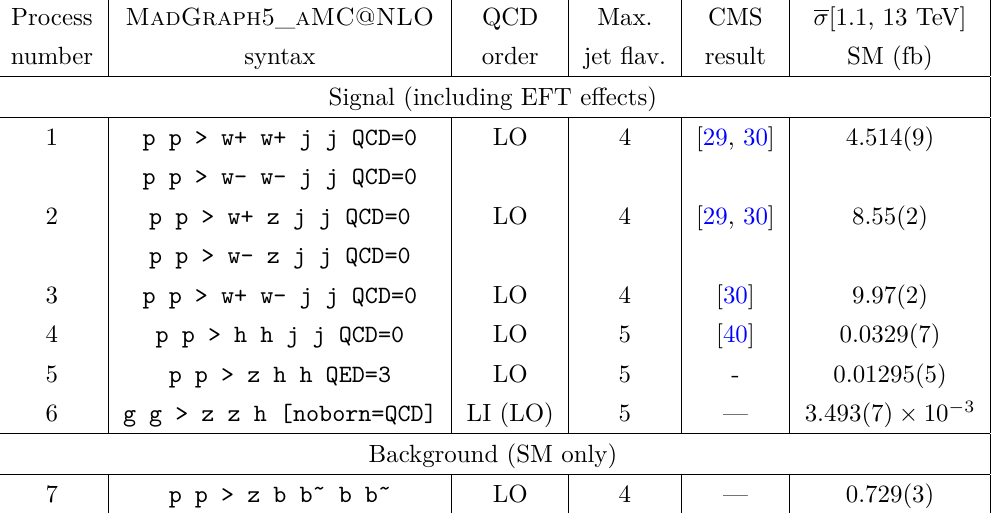
Table 1 . LHC processes of interest studied in the present work, numbered according to the main text. The number of active flavours considered in protons and jets is also listed. σ [ m ] min , m max is the cross section in the interval m , with m being the invariant mass of the min ≤ m ≤ m max produced di- or tri-boson final state. Each cross-section value is evaluated after cuts on final-state jets described in the text and reports in brackets the integration uncertainty on the last digit. The parton distribution functions used in the simulations are taken from the